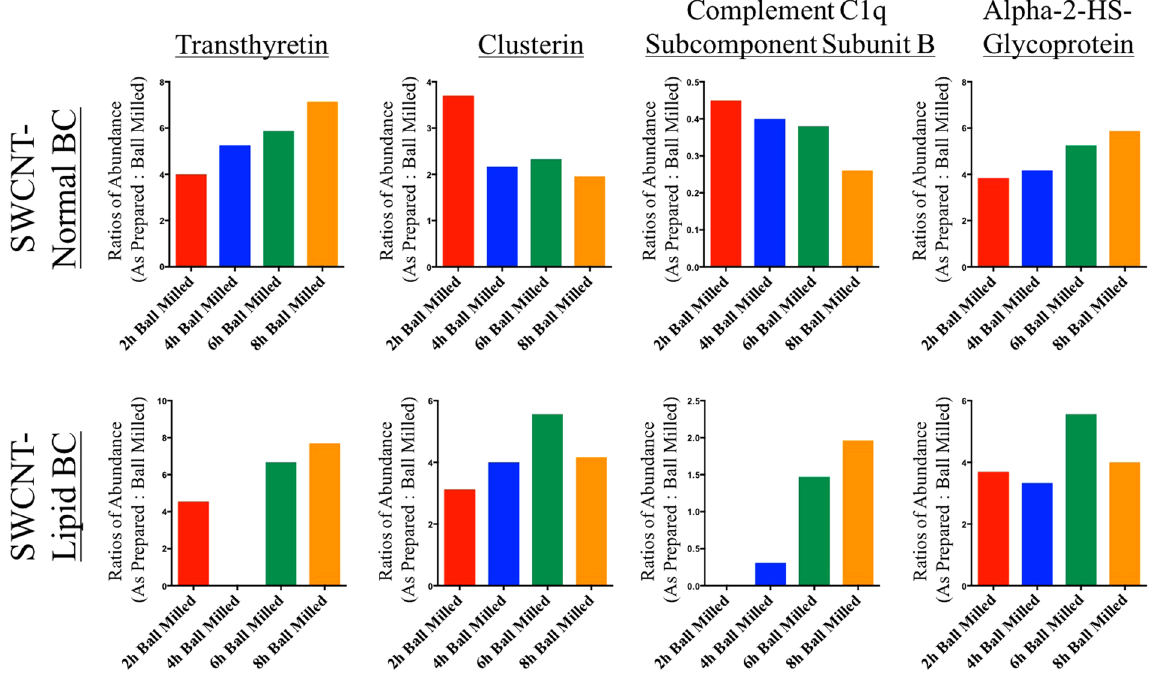
Figure 4. Differences in relative abundance of specific proteins (Transthyretin, Clusterin, Complement C1q Subcomponent Subunit B, and Alpha-2-HS-Glycoprotein) found to associate with SWCNTs in either